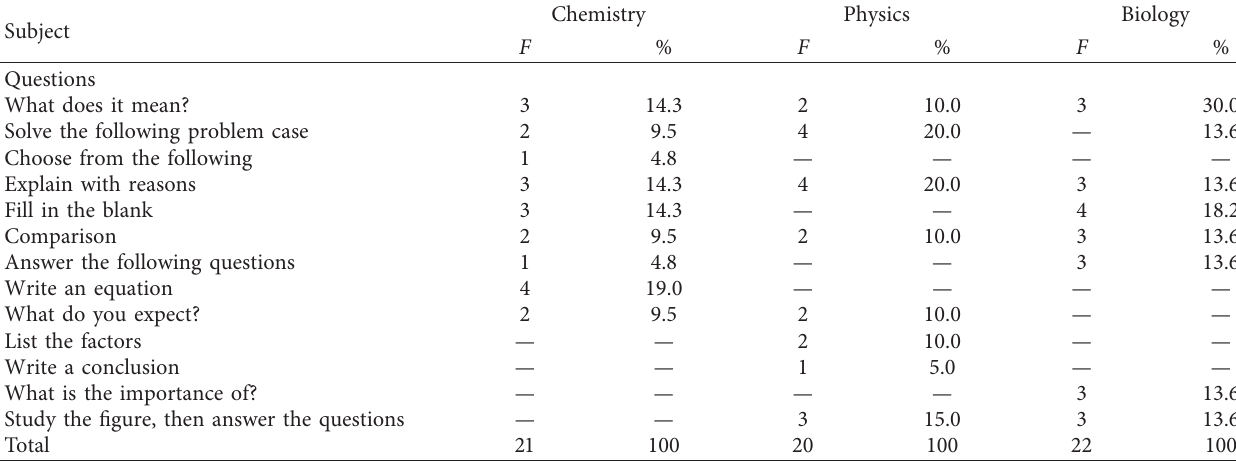
Table 10: Final examinations’ frequency distribution of long answer questions for chemistry, physics, and biology.